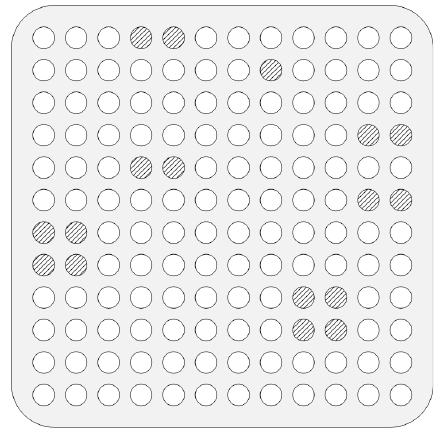
Figure 10. The tok_mask matrix.